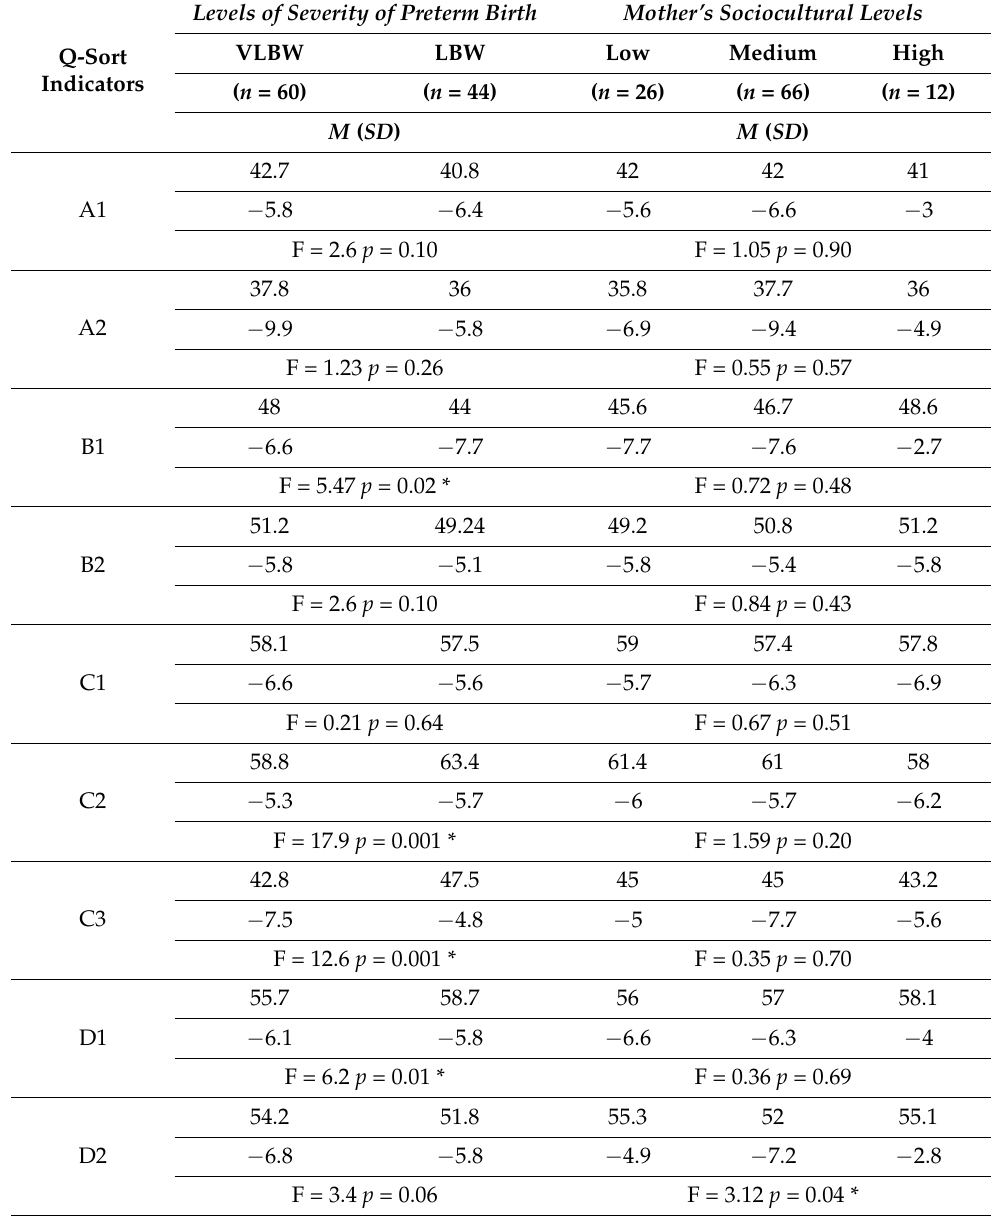
Table 5. Maternal competence (Q-sort scores) in NICU (T1) in relation to levels of severity of preterm birth, mother’s sociocultural level (MANOVA) ( n = 104). Levels of Severity of Preterm Birth Mother’s Sociocultural Levels VLBW LBW Low Medium Q-Sort Indicators